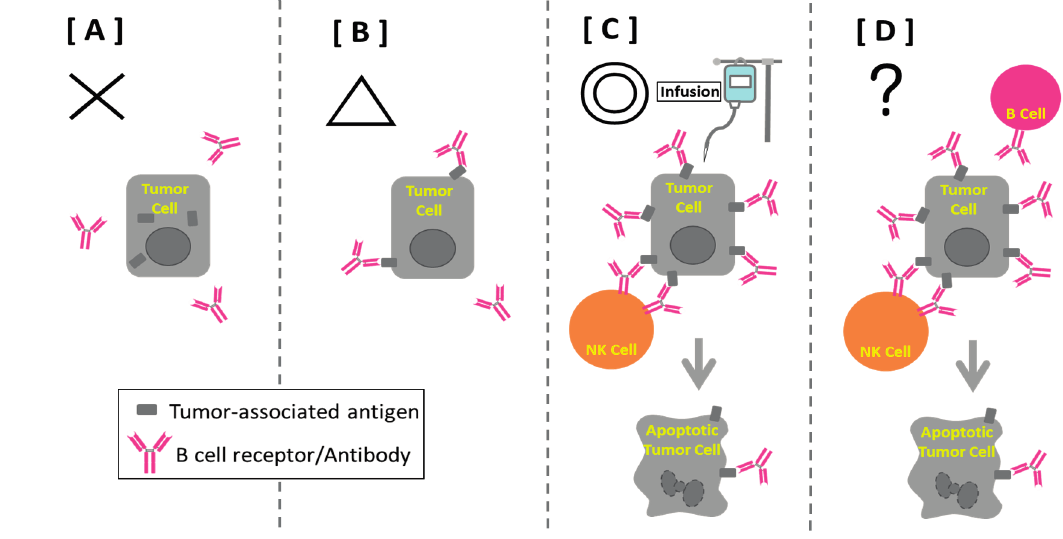
Figure 3. Antigen expression determines the effect of antibody-based passive